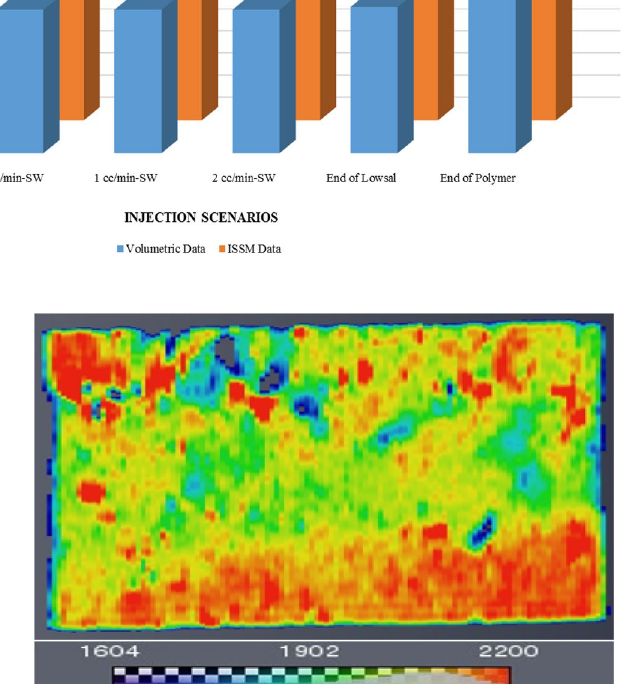
Fig. 15 Comparison between volumetric production data and in situ saturation monitoring data during Exp. 3